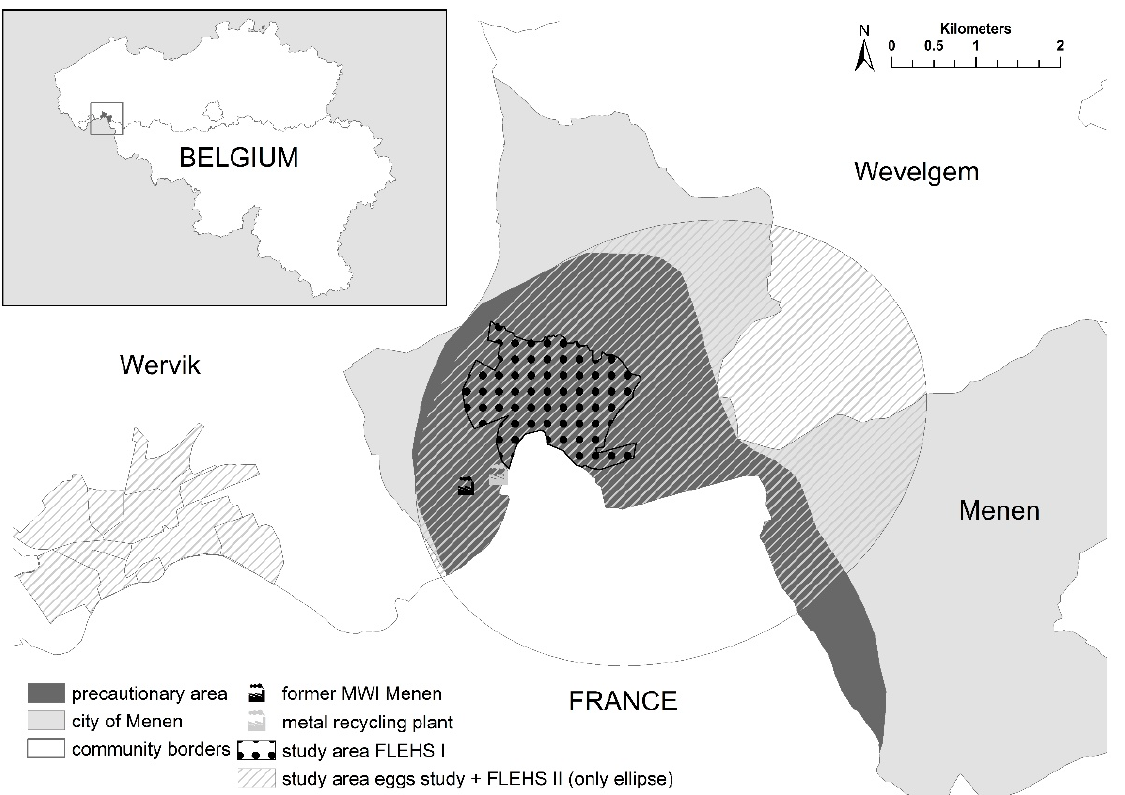
Figure 1. Time-flow of the sequence of research activities on polychlorinated dibenzo-p-dioxins and furans (PCDD/Fs) and polychlorinated biphenyls (PCBs) in the region of Menen. Activities in the grey boxes are addressed in this article. FLEHS = Flemish Environment and Health Study.